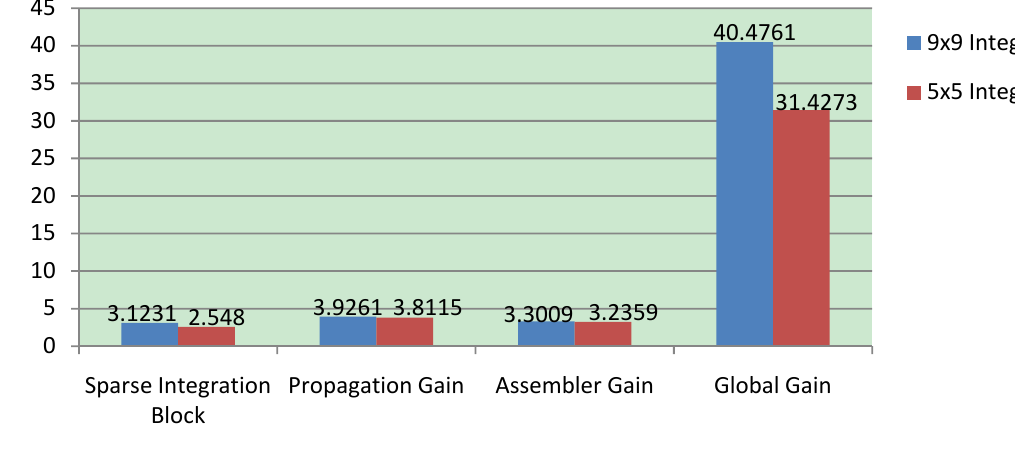
Figure 3. Comparison of the gains obtained with the different optimization strategies. Two different implementations are evaluated here, 5 × 5 (red bars) and 9 × 9 (blue bars). (Left to right) The first group of columns represents the Sparse Integration Block (SIB) factor gain; the second group shows the obtained gain after applying the optical flow 4:1 propagation. In the third column group figure the gain when the method is optimized in assembler while last column show total gain factor obtained after all the approaches are